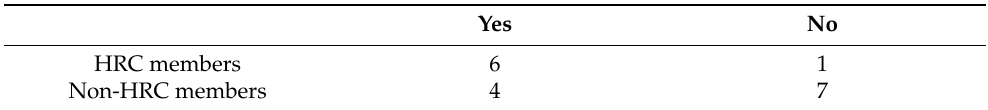
Table 10. Responses regarding whether the observation site had ever come up in conversation among community residents.